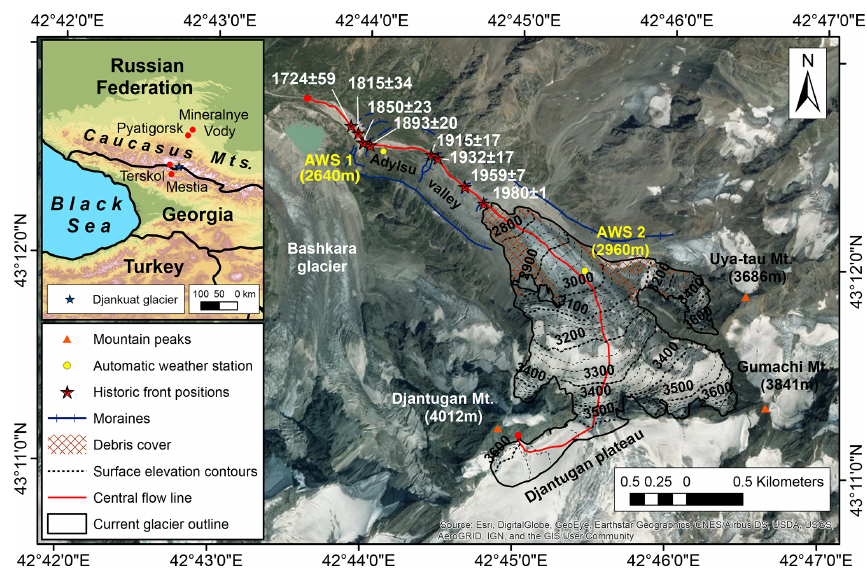
Figure 1. Satellite image of the Djankuat Glacier for the year 2010CE, showing the most important features in the study area.